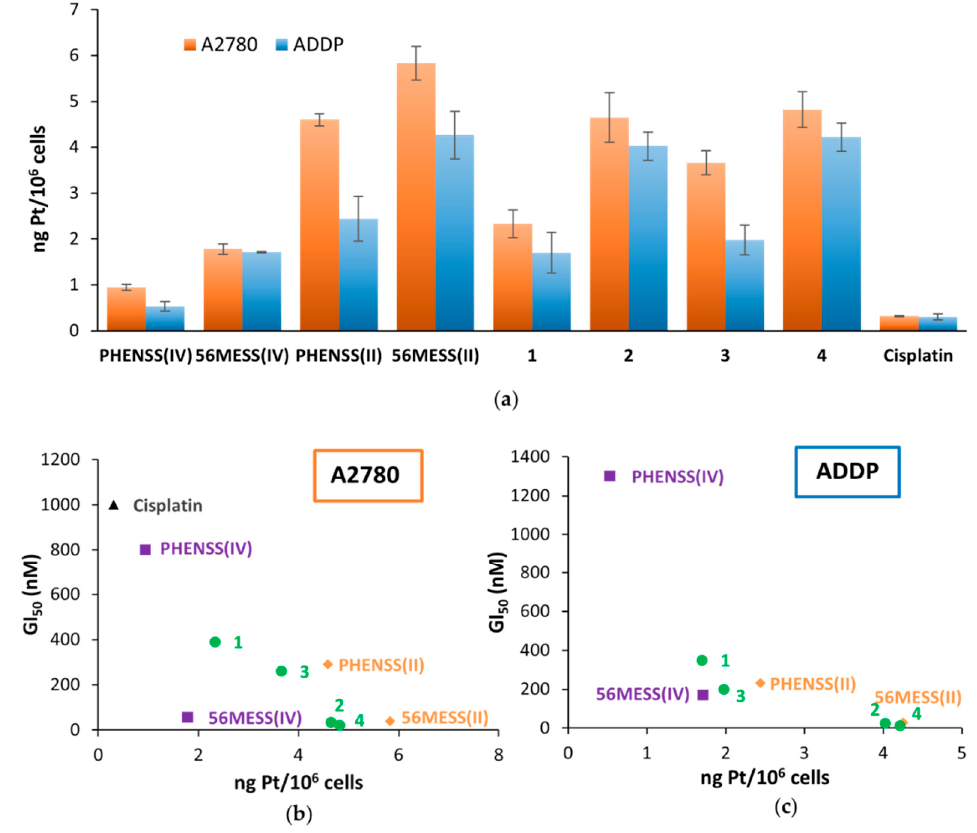
Figure 9. ( a ) Cellular accumulation levels of 1 – 4 , their platinum(II) and platinum(IV) precursors and cisplatin against A2780 (ovarian) and ADDP (cisplatin-resistant ovarian) cancer cells that were treated with 1.0 µ M for 4 h. Values are reported in ng Pt/10 6 cells, are reported with standard error of the mean, and were produced from three independent experiments. ( b ) and ( c ): The correlation between the cellular accumulation and cytotoxicity of 1 – 4 , their platinum(II) and platinum(IV) precursors and cisplatin against A2780 ( b ) and ADDP ( c ) cancer cells treated with 1.0 µM for 4 h. Note: in order to avoid skewing the graph in ( c ), data for cisplatin have been omitted as its GI 50 value against the ADDP cell line was 28000 nM.